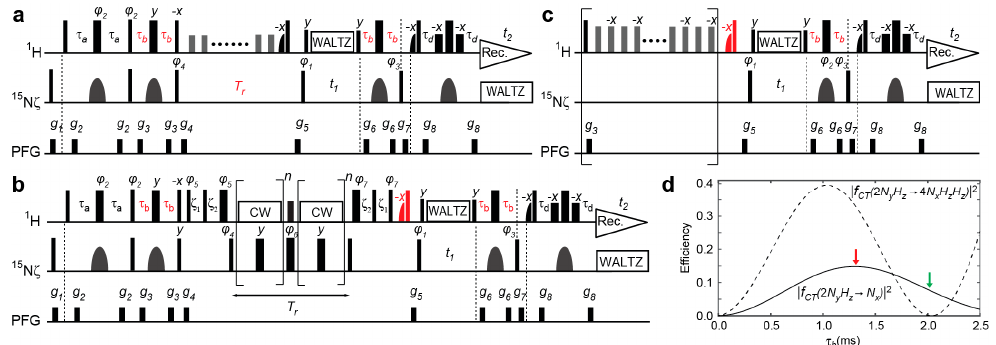
Figure 1. Pulse sequences for the 15 N relaxation measurement on lysine side-chain NH 3+ groups. The key elements in the current work are indicated in red. Thin and bold bars in black represent hard rectangular 90 ◦ and 180 ◦ pulses, respectively. Water-selective half-Gaussian (2.1 ms) and soft-rectangular (1.2 ms) 90 ◦ pulses are represented by half-bell and short-bold shapes, respectively. Unless indicated otherwise, pulse phases are along x , and the carrier position for 1 H was set to the position of the water resonance. The 15 N carrier position was set to 33.1 ppm. A gray bell-shape for 15 N represents an r-SNOB [36] 180 ◦ pulse (1.0 ms) selective to Lys side-chain 15 N ζ nuclei. The delays τ a and τ b were 2.7 ms and 1.3 ms, respectively. Quadrature detection in the t 1 domain was achieved using States-TPPI, incrementing the phase ϕ 1 . Pulsed field gradients (PFGs) were optimized to minimize the water signal. ( a ) 15 N R 1 measurement. Although it is not essential owing to negligible CSA-DD cross correlation for NH 3+ , a 1 H 180 ◦ pulse, which does not affect H 2 O resonance, was applied every 10 ms during the delay T r for longitudinal relaxation. Phase cycles: ϕ 1 = (2 y , 2( − y )), ϕ 2 = ( y , − y ), ϕ 3 = (4 x , 4( − x )), ϕ 4 = (8 y , 8( − y )), and receiver = ( x , − x , − x , x , 2( − x , x , x , − x ), x , − x , − x , x ); ( b ) 15 N R 2 ,ini measurement. The RF strength for 15 N pulses for the CPMG scheme was 5.4 kHz. The 1 H carrier position was shifted to 7.8 ppm right after the PFG g 4 and set back to the position of water resonance right after the PFG g 5 . The RF strength ω CW /2 π of 1 H CW during the CPMG was set to 4.3 kHz, which